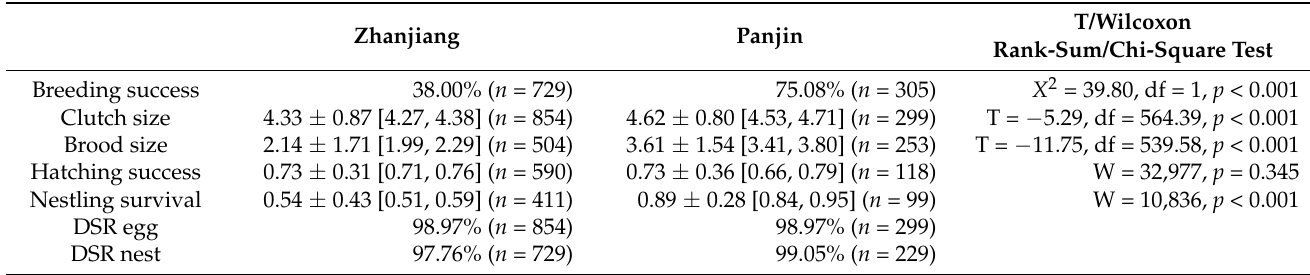
Table 1. Reproductive parameters of two Barn Swallow populations in tropical (Zhanjiang) and temperate (Panjin) climate